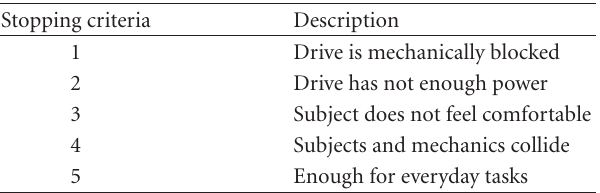
Table 5: Description of the stopping criteria.